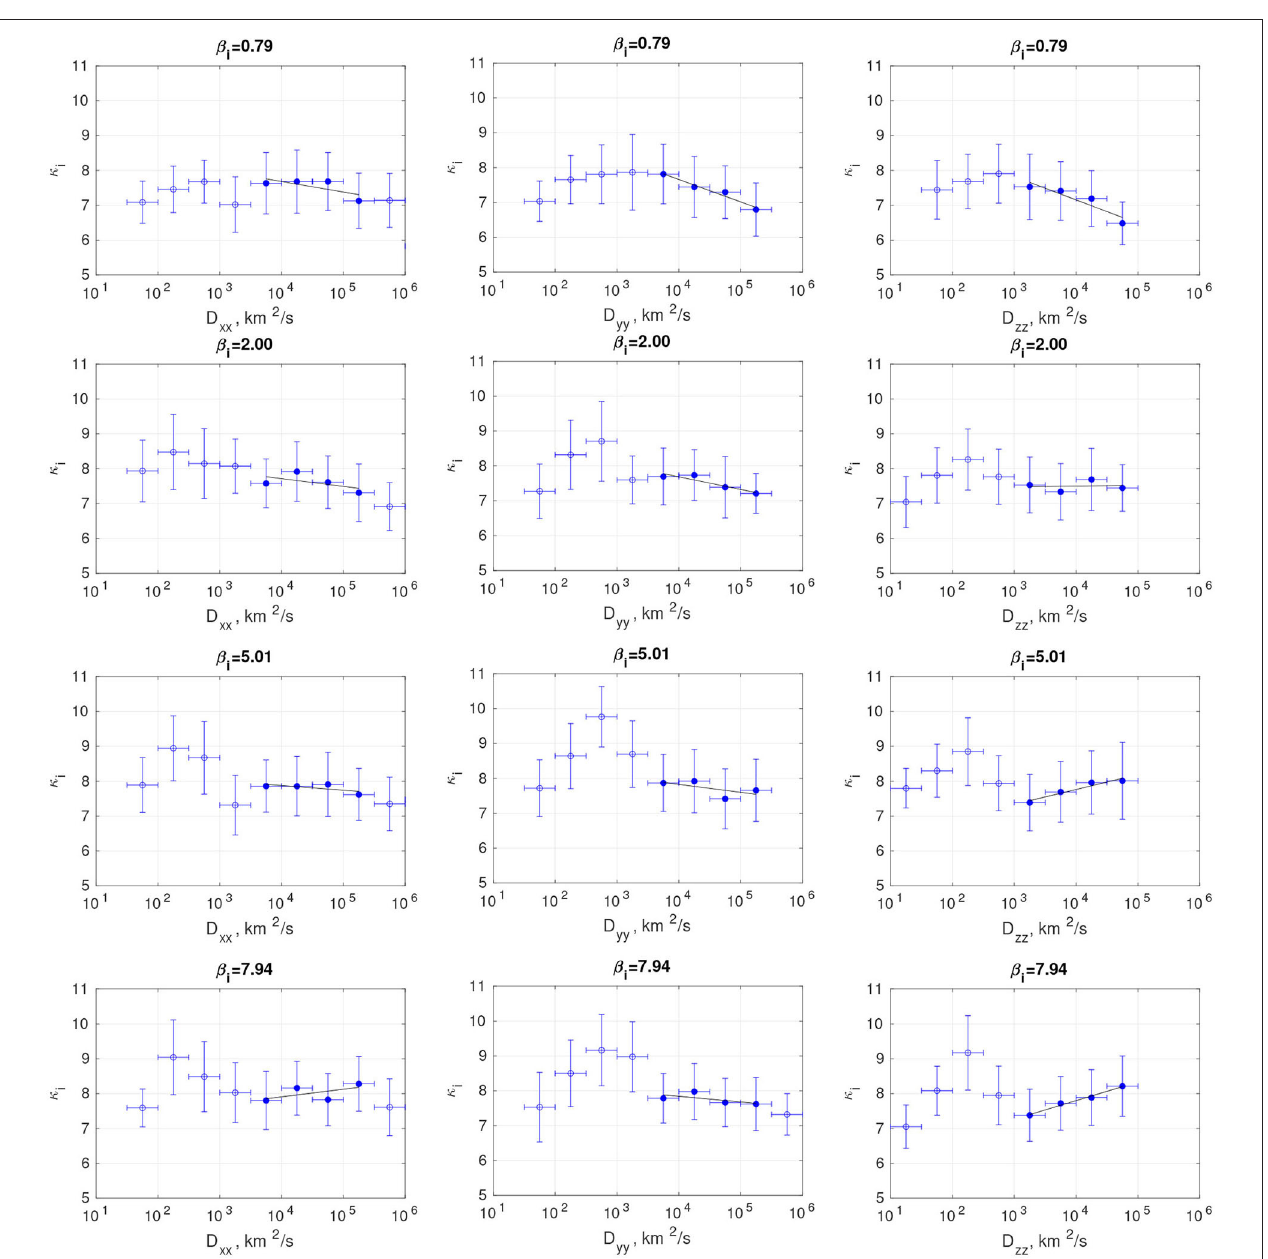
FIGURE 6 | Dependence of ion κ indices on mean log 10 D for different plasma β . The first column is for D xx , while second and third columns are for D yy and D zz , A log 10 D B was fitted to the points plotted with filled circles, and the results are plotted with a solid respectively. The function κ = +